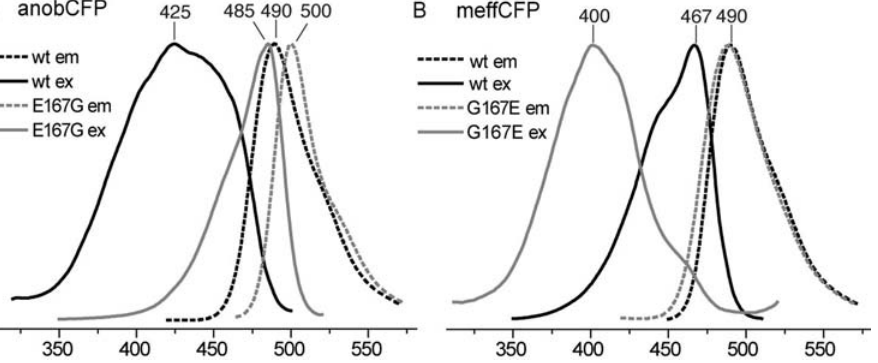
Figure 5. Glutamic acid at position 167 (numeration according to GFP) determines the ‘‘neutral-chromophore’’ phenotype in novel cyan fluorescenr proteins. A: Replacement of native E 167 by glycine in anobCFP leads to disappearance of 425 nm excitation peak and shift of both excitation and emission curves towards green. B: Reciprocal replacement G167E in a cyan protein meffCFP leads to the opposite results: virtually all the protein bulk started absorbing at 400 nm. Notably, the emission peak did not change.